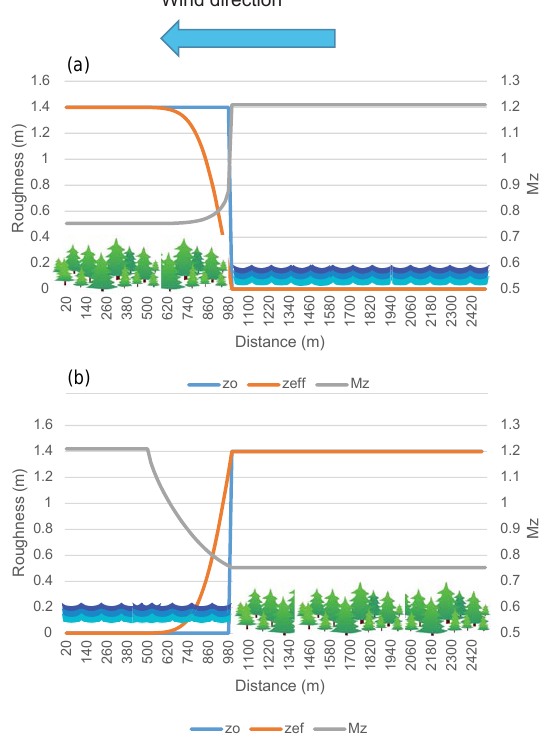
Figure 2. The value of surface roughness lengths z 0 and z eff and the surface-roughness-dependent wind multiplier ( M z ) in cases where wind is from lake to forest (a) and from forest to lake (b) .